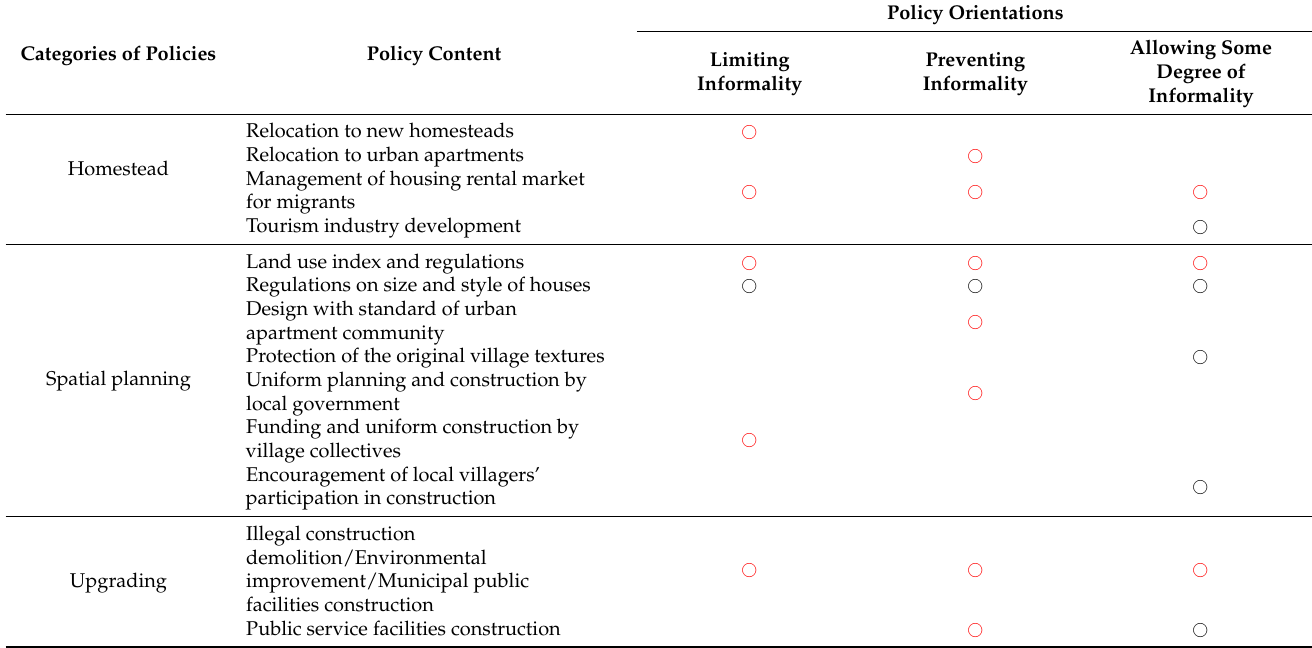
Table 1. Summary of the three policy orientations of the different urbanization stages.